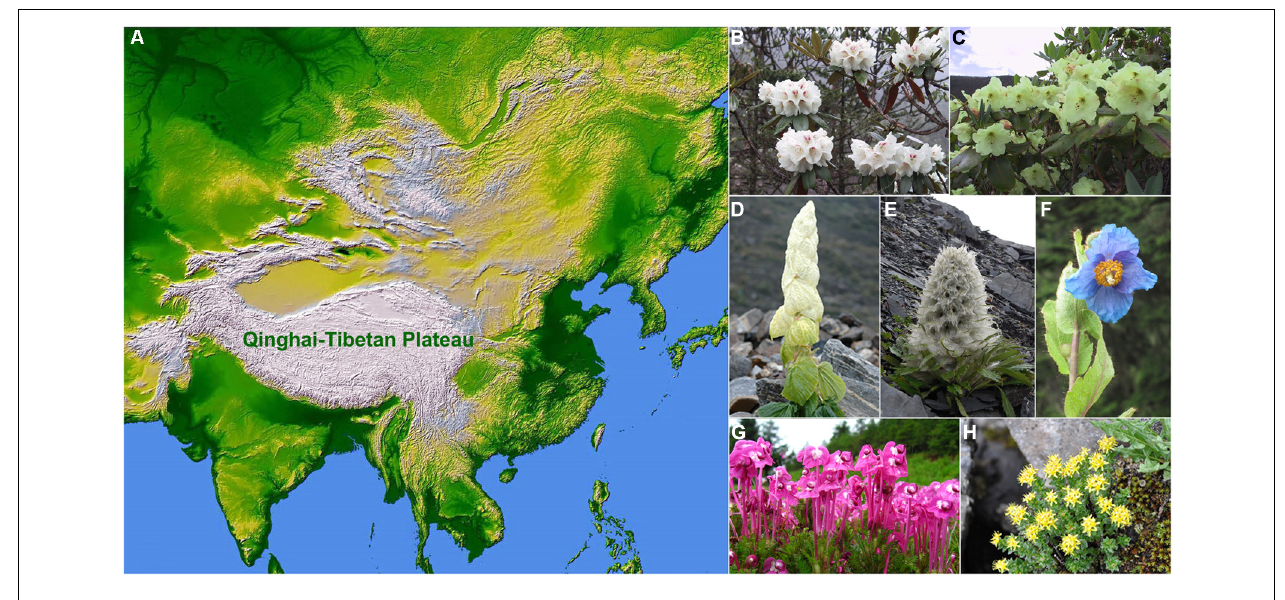
“snow-ball” morphology; (F) Meconopsis betonicifolia Franch.; (G) Pedicularis siphonantha D.Don var. delavayi (Franch. ex Maxim.) P.C.Tsoong; and (H) Rhodiola alsia (Fröd.) Fu (photo credit: B,C,G by H. Sun; D,F by J. Wen; E by B. Song; and H by J. Q.